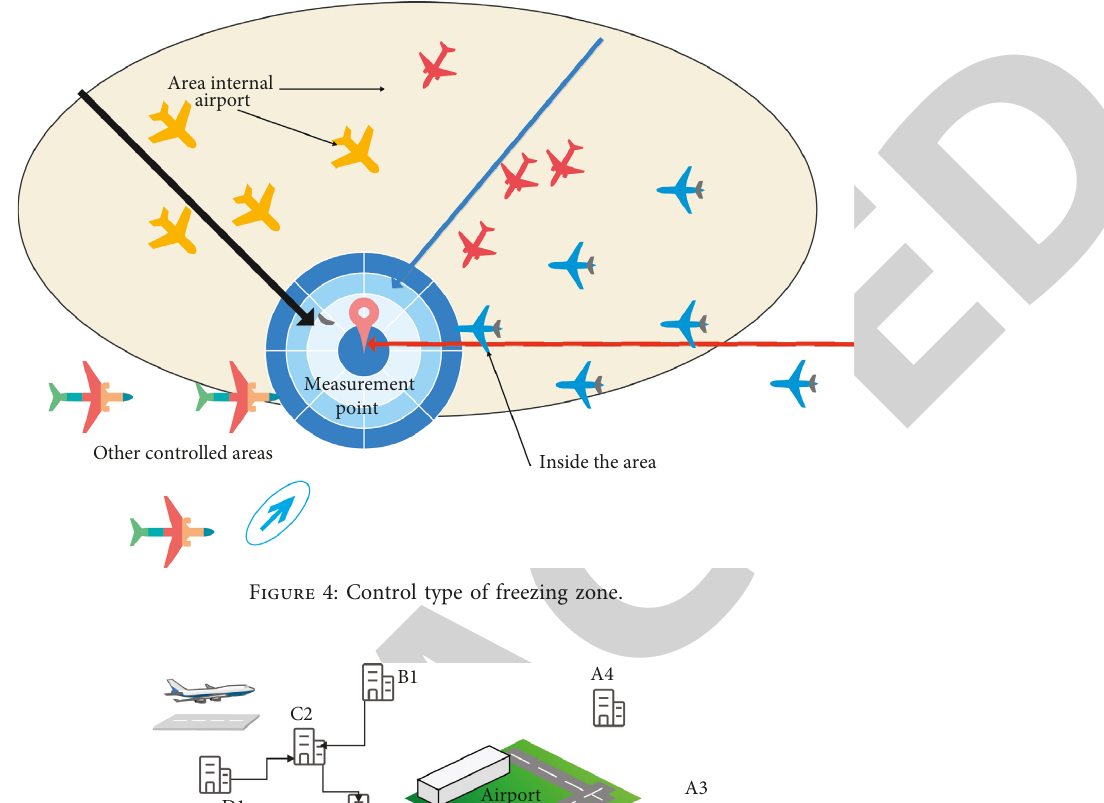
Figure 5: Schematic diagram of split node.